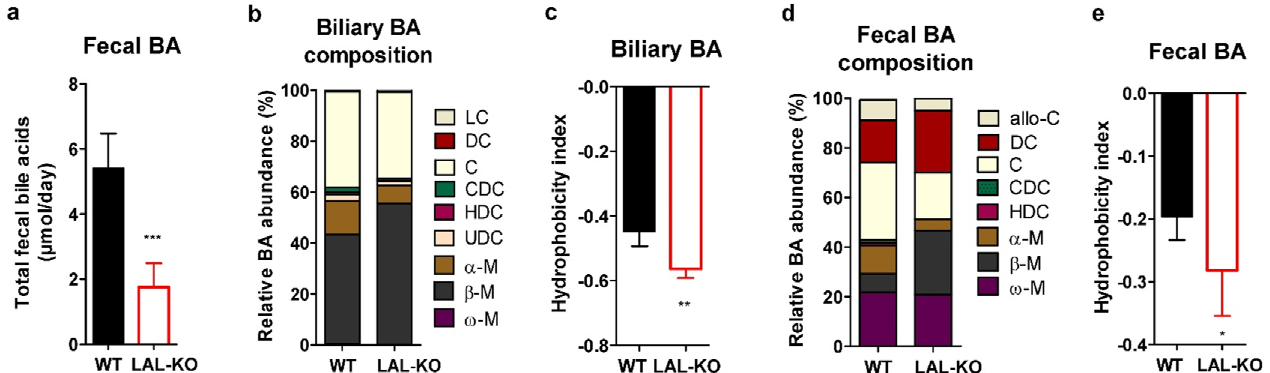
Figure 5. Altered bile acid composition in WTD-fed LAL-KO mice: ( a ) Total bile acid levels in feces, bile acid composition in the ( b ) gallbladder, and ( d ) feces. Heuman’s hydrophobicity index of ( c ) biliary and ( e ) fecal bile acids of WTD-fed male mice (12–14 weeks of age). Data represent mean values + SD (n = 4–6); p < 0.05 (*), p ≤ 0.01 (**), p ≤ 0.001 (***); Student’s unpaired t-test.